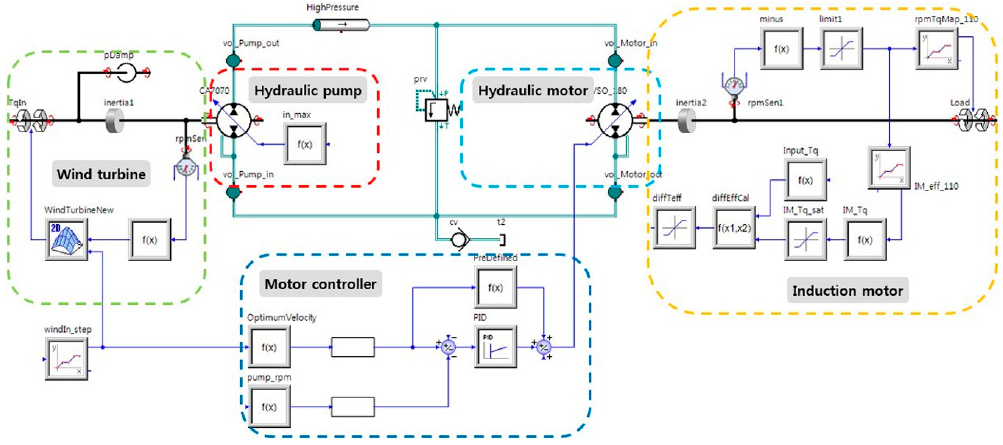
Figure 8. Development of a simulation environment of the wind turbine generator: Step 1.